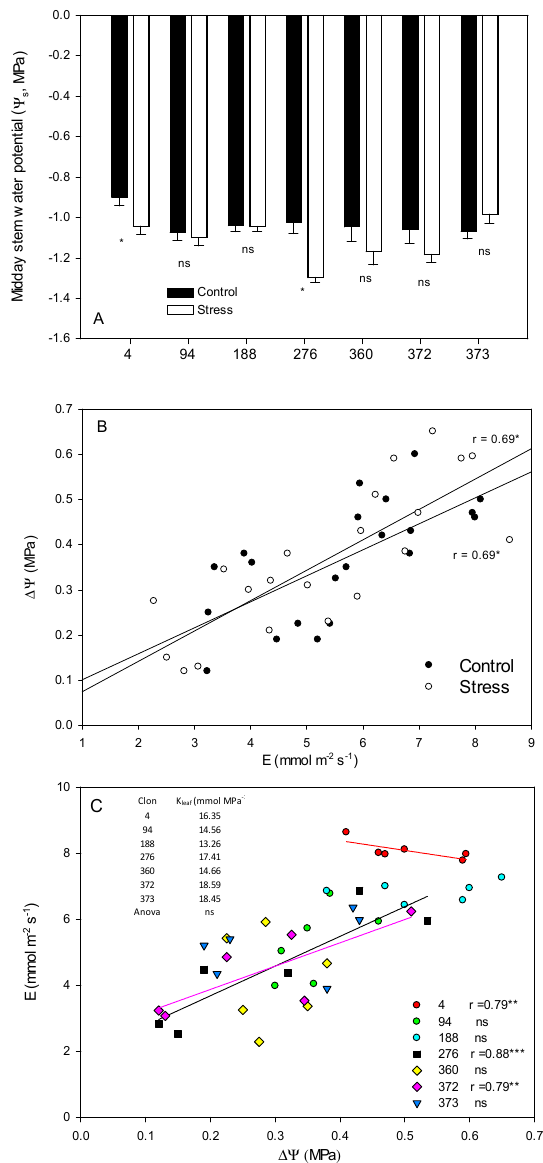
Figure 3. A. Differences in midday stem water potential ( Ψ s ) between control and stress treatments for each clone during post-veraison periods (average data from two years: 2020 and 2021). B. Significant linear relationship between leaf transpiration rate (E) and Δ Ψ ( Ψ l - Ψ s ) measured at midday during post-veraison in 2020. *P <0.05. In B, points represent data from all of the clones. C. Significant relationships between gradient of water potential in the leaves and leaf transpiration measured at midday for each clone, during post-veraison period in 2020 (August, 20 th 2020). In C, each single point is a single measurement made in the same leaf in a vine. K leaf was calculated in August 2020 for each clone using the evaporative flux method (see Material and methods). ns, not significant, * P <0.1, ** P <0.05, *** P<0.01.